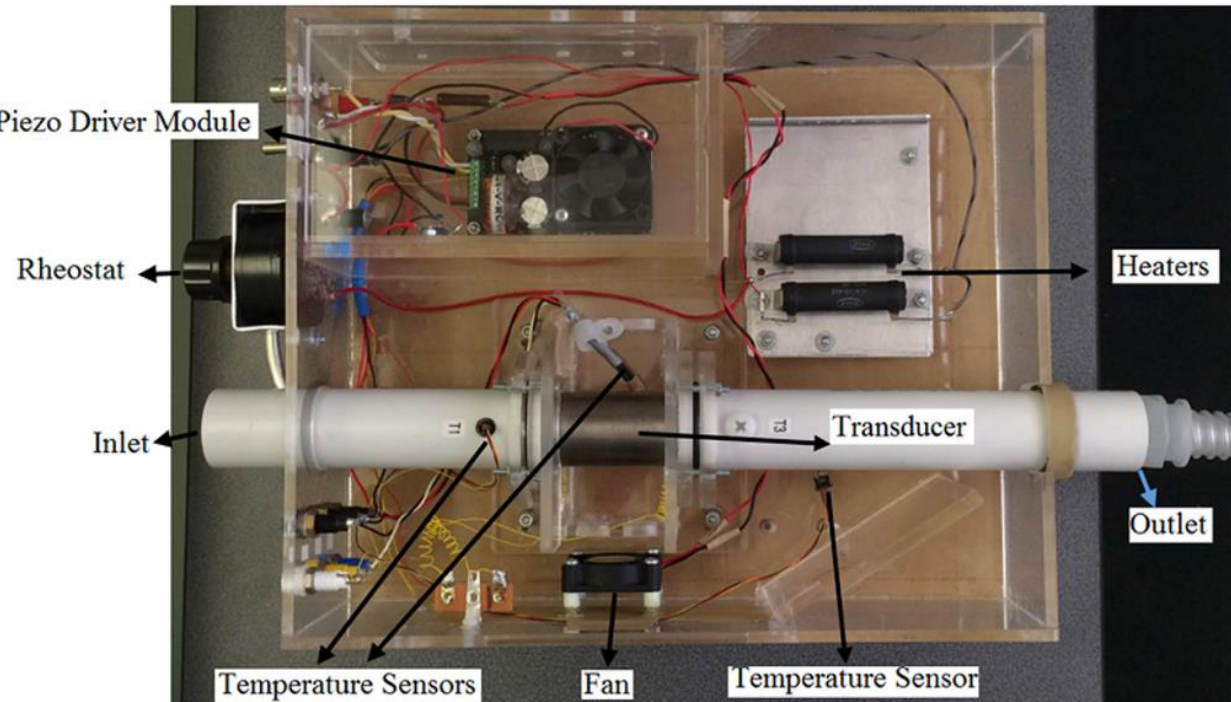
Figure 7. The experimental set-up includes a stepped-thickness cylindrical transducer to acousti- cally enhance evaporation of a stream of polydisperse microwater droplets